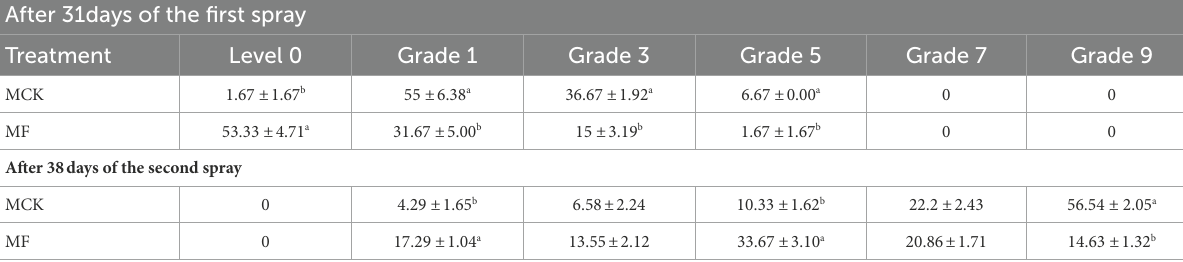
TABLE 2 Root-knot disease graded (1–9) in the root system of Cucumis melo var. saccharinus treatment groups (MCK and MF). After 31 days of the first spray